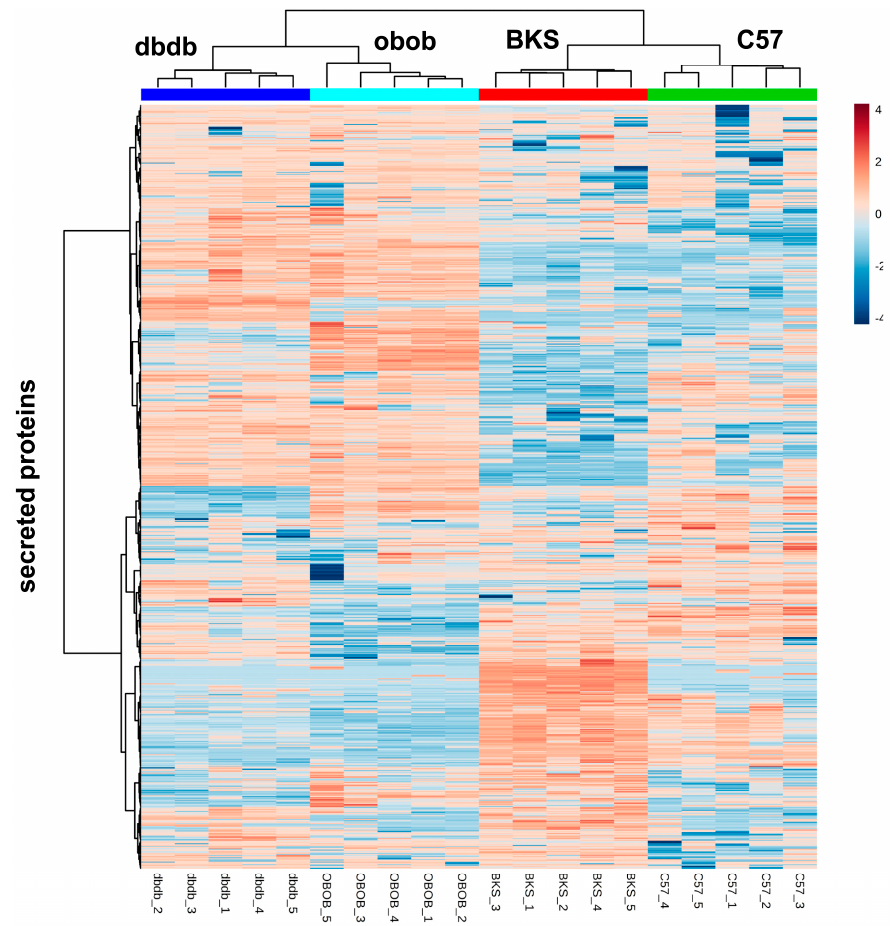
Figure 2. Heatmap of all identified adipokines.